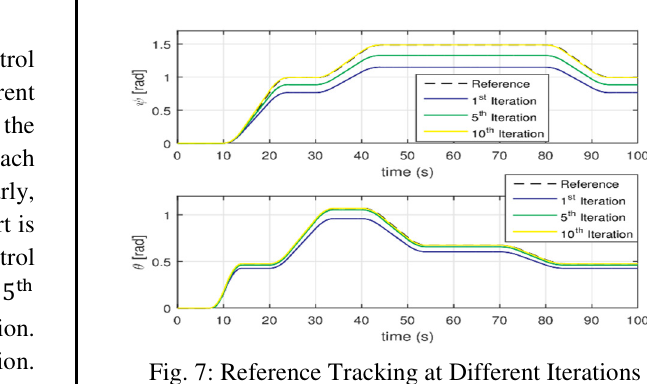
Fig. 7: Reference Tracking at Different Iterations Using Hybrid